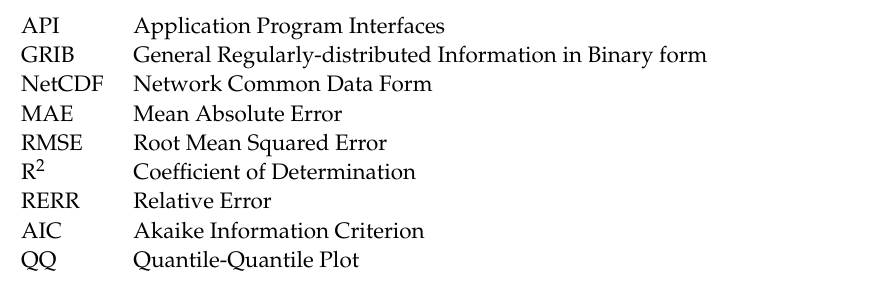
Table A1. Review of linear models and random forest models, where evaporation E [mm · month − 1